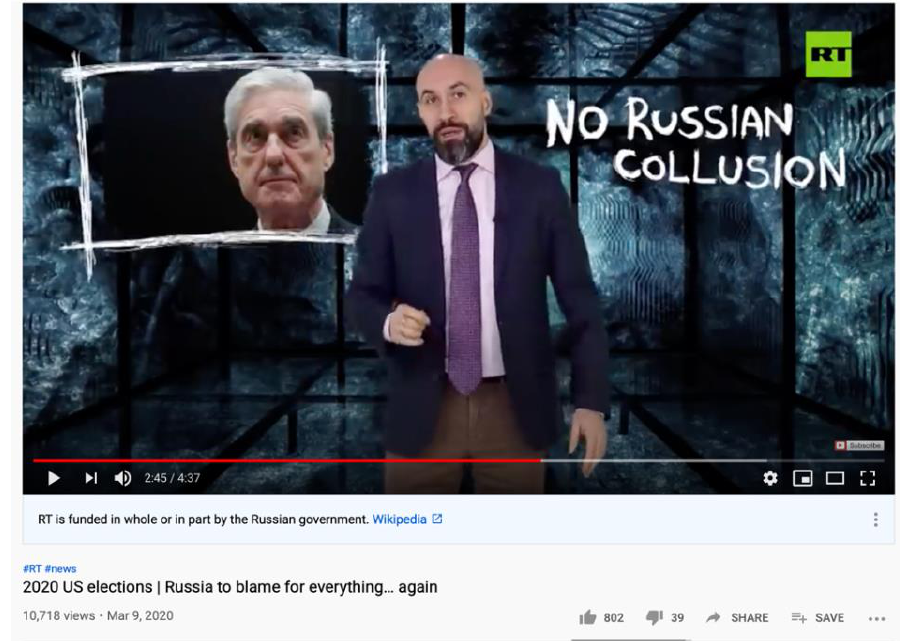
Figure 1. An RT video used in our study with the warning label visible